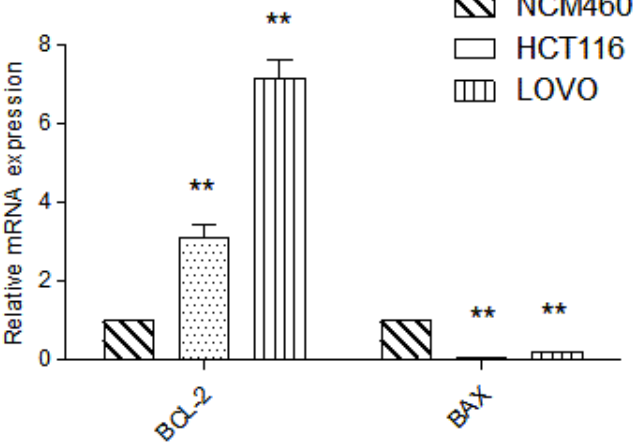
Figure 7. Changes in the expression of mitochondrial apoptosis-related genes BCL-2 and BAX in human normal intestinal epithelial cells NCM460 and colon cancer cells HCT116 and LOVO. n = 3; Compared with the blank group, ** p < 0.01, each data point represents the mean ± standard error.